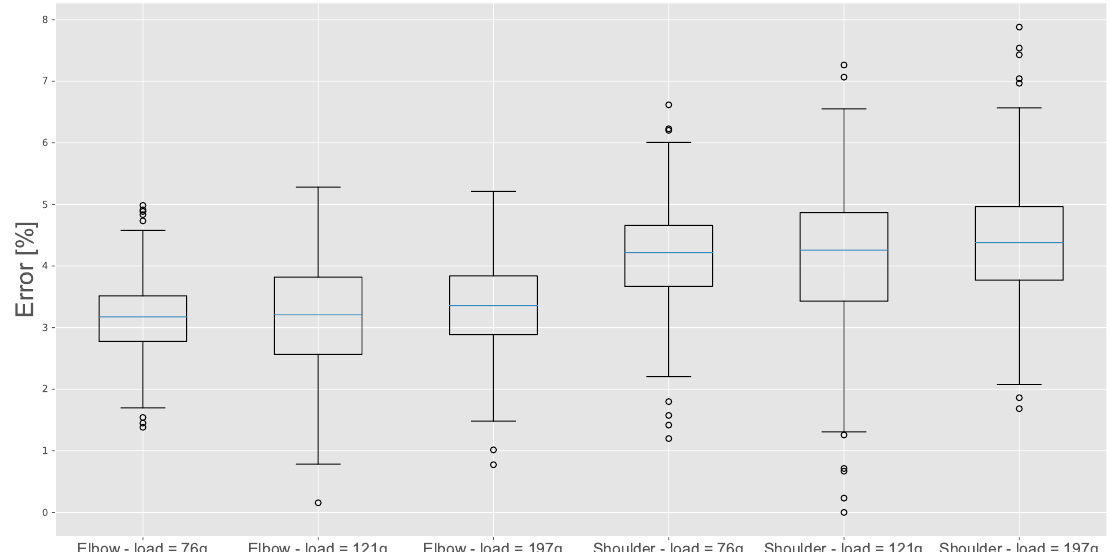
Figure 14. Analysis of the normalized error with two degrees of freedom in tests with different loads.